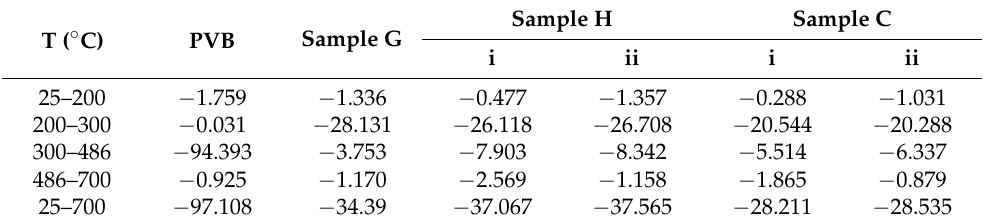
Figure 8. TG curves of the single PVB and samples G, H and C containing Al(OH) 3 . Table 2. The weight change (wt.%) of the single PVB, samples G, H and C at different temperature